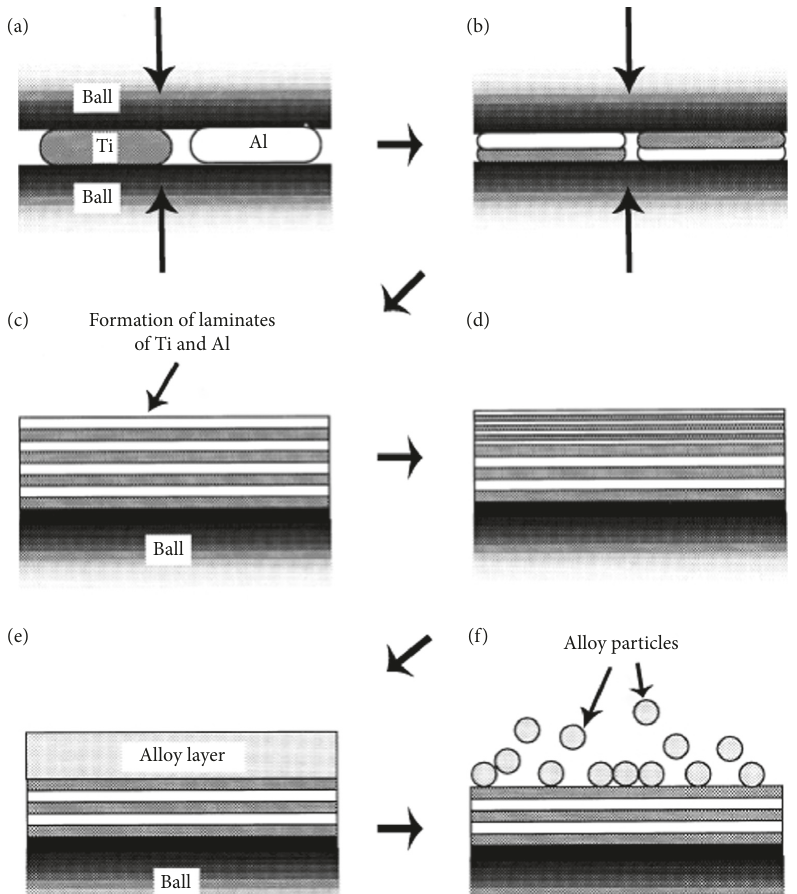
Figure 8: Schematic illustration showing the mechanical alloying process of Ti and Al: (a) formation of flaky Ti and Al particles by ball impact; (b) cold welding of flaky particles on ball surfaces and mill container wall; (c) formation of laminates of Ti and Al on milling balls and container wall; (d) refinement of layered structure of the laminates; (e) formation of alloy layer on the surface of laminates; (f) formation of alloy particles by breakage of the alloy layer, as adopted from